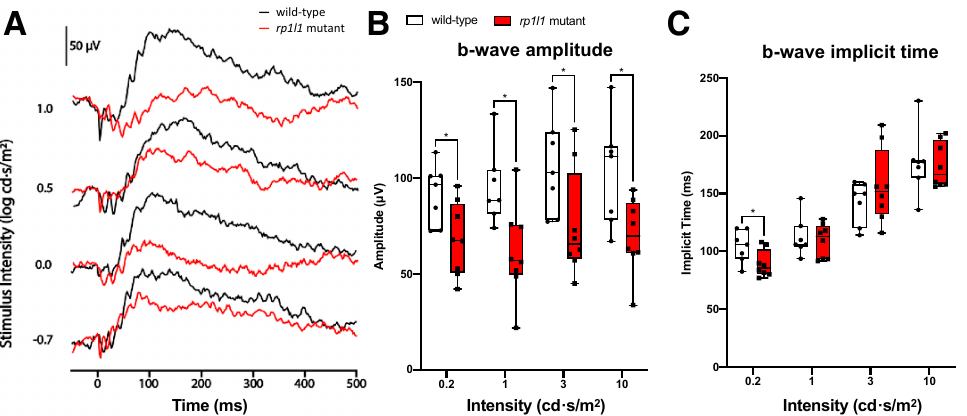
Figure 4. rp1l1 is required for the normal photoreceptor physiological response in aged animals. ( A ) Sample traces from a 12-month-old wild-type and rp1l1 mutant fish. ( B ) b-wave amplitude for wild-type and rp1l1 mutants. The rp1l1 mutant zebrafish have a significantly decreased b-wave amplitude under all light intensities. ( C ) b-wave implicit time for the wild-type and mutant zebrafish. The mutants have a significantly faster b-wave under the 0.2 cd · s / m 2 intensity. The box and whisker plots depict medians and distributions, with all animals plotted. n = 7 for wild-type; n = 8 for mutants. * p < 0.05.